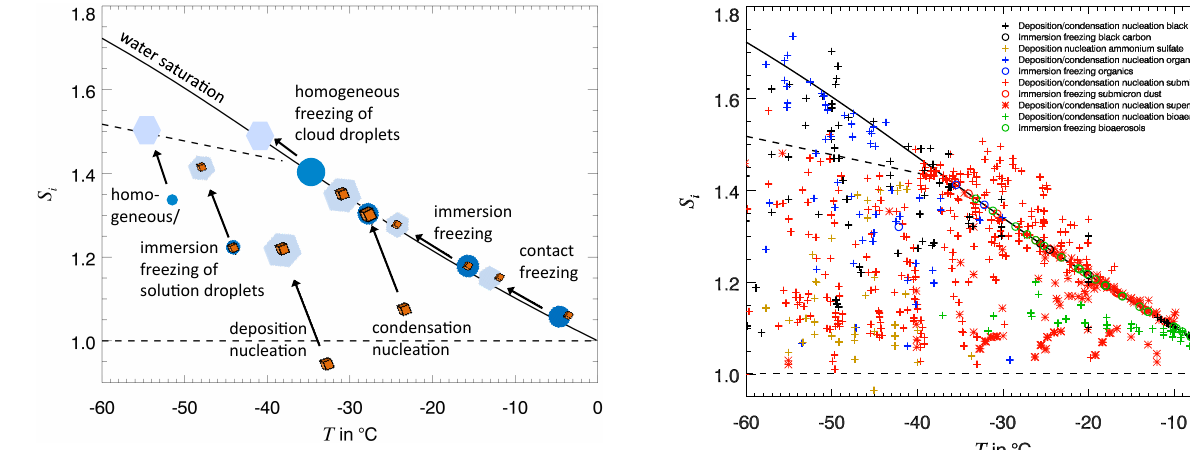
Fig. 2. Overview of ice nucleation onset temperatures and satura- tion ratios. Data sources are listed in the following